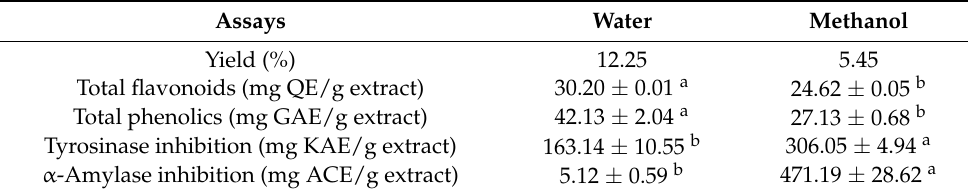
Table 3. Extraction yield, enzyme inhibition activity, total phenolic and flavonoid contents of S. cretica ssp. anatolica extracts x.